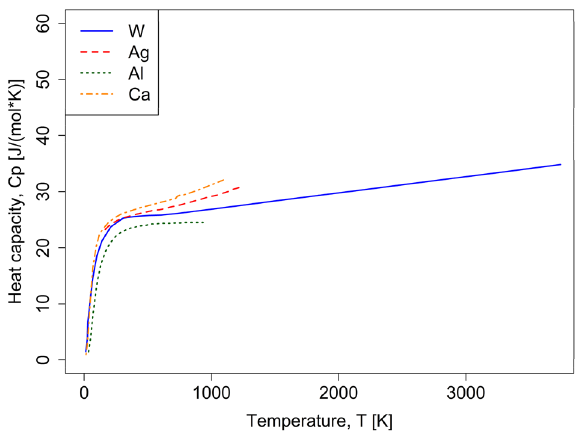
Figure 1. DFT-based heat capacity calculations without vacancy contributions [quasiharmonic, electronic and anharmonic contributions only] for W 34 , Al 34 , Ca 35 and Ag 30 . Each line ends at the melting point of its respective